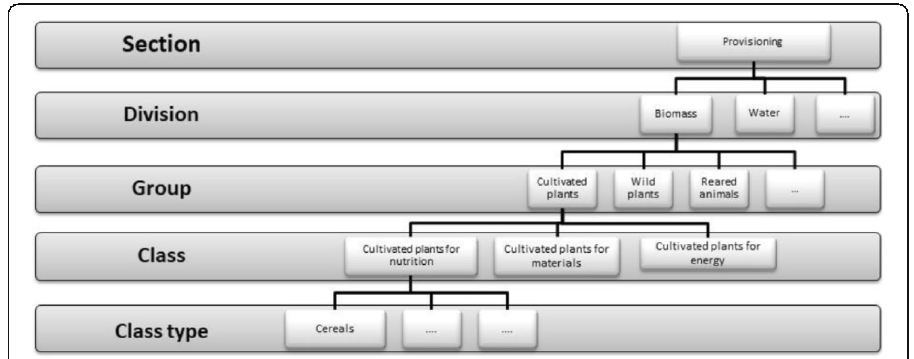
Fig. 7 The five-level hierarchical structure of the ecosystem services by CICES (CICES